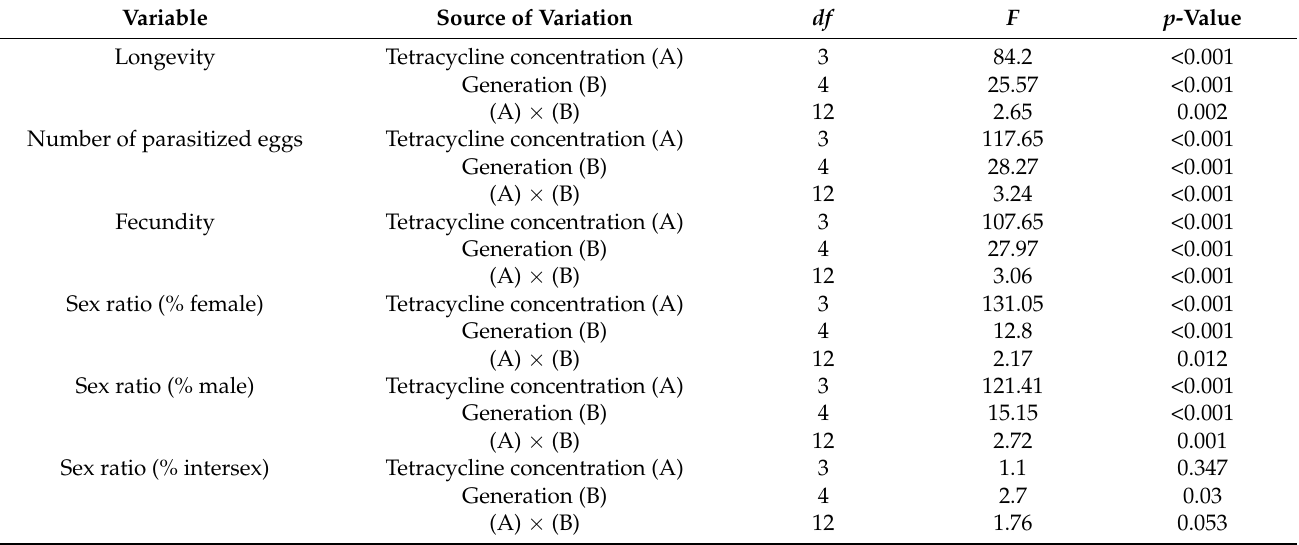
Table 2. Analysis of effects of tetracycline concentrations and generations on biological parameters of treated female parasitoids and their